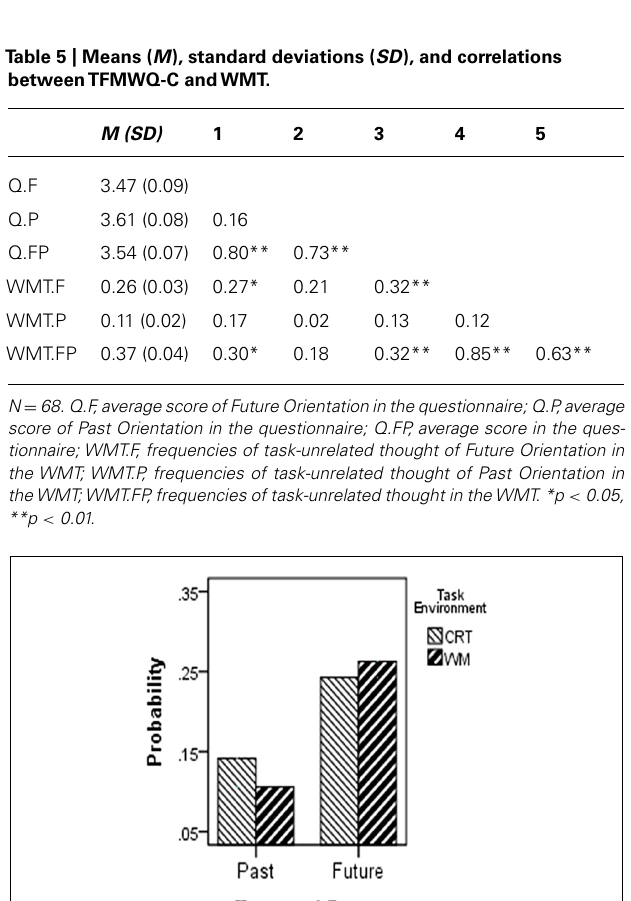
are two possible reasons for the result. One reason may lie